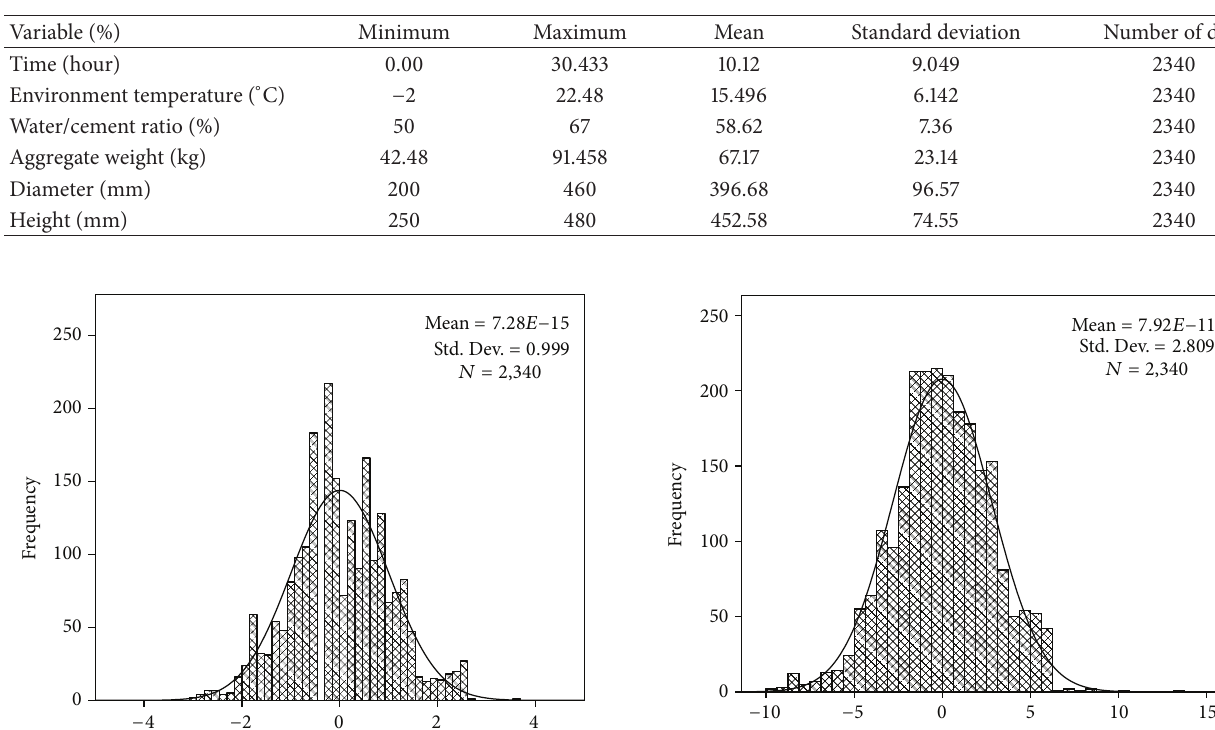
Table 2: The range of variables.